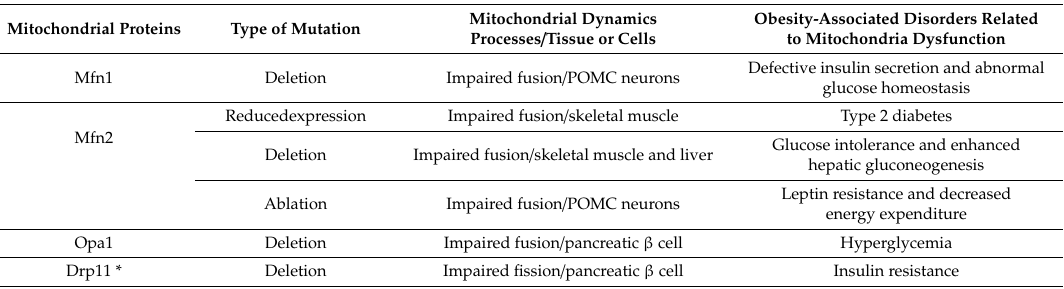
Table 1. Mitochondria play an important function in energy metabolism, and a dysfunction of their processes, due to mutations in some mitochondrial genes (in particular mitofusin, Opa1, and Drp1), is implicated in the pathophysiology of obesity and